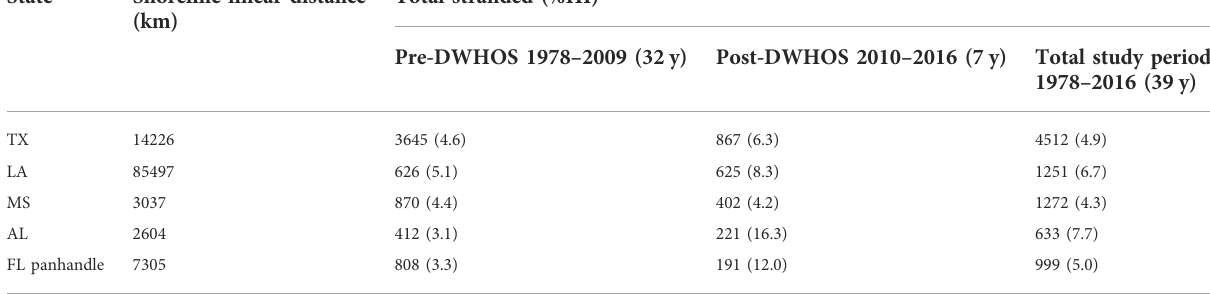
TABLE 2 The total number (and percent HI-positive) of T. truncatus strandings compared to linear shoreline distance of nGOM states (shown in Figure 1) during the 39-year study period, separated by time periods pre- (1978 – 2009) and post- (2010 – 2016) DWHOS. FL panhandle includes shoreline from the Alabama-Florida border through Jefferson County, FL.